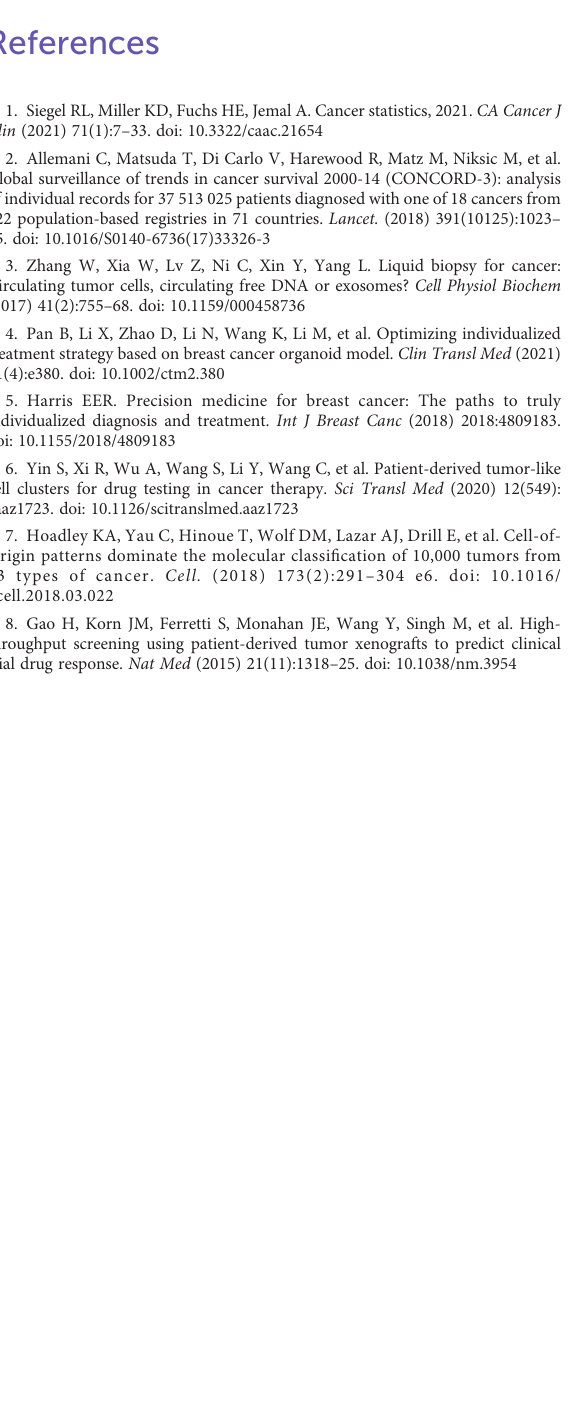
SUPPLEMENTARY TABLE 1 Detailed patient information for evaluating the clinical ef fi cacy.